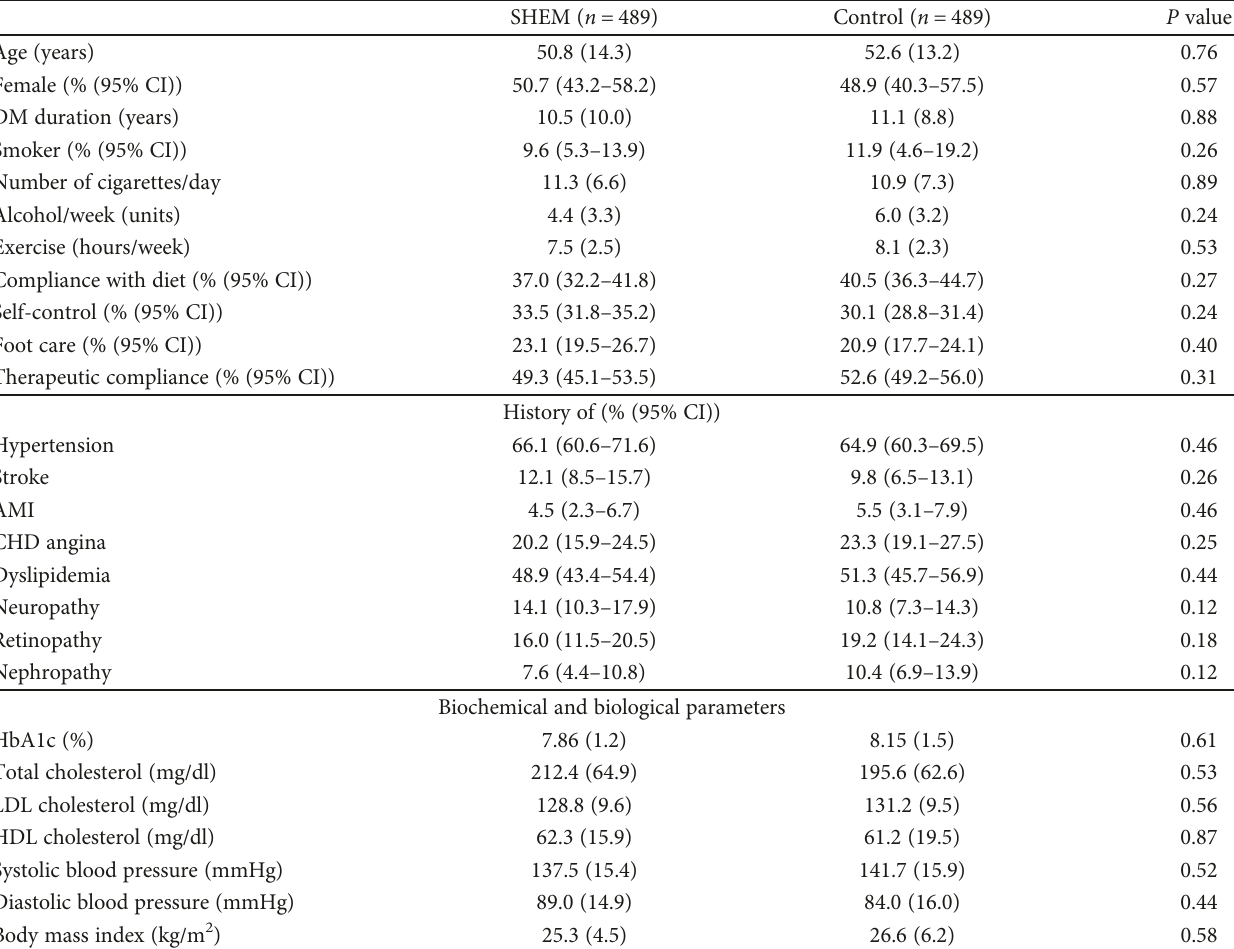
Table 1: Baseline characteristics of